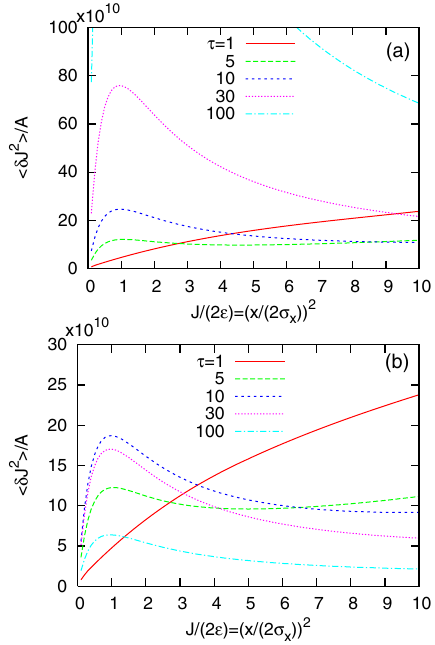
FIG. 18. Diffusion rate given by Eq. (32) as a function of J= ð 2 ϵ Þ for equal tunes δμ ¼ 0 (top) or with a tune difference of δμ ¼ ξ ¼ 0 . 01 (bottom). The rate on the vertical axis is normal- ized by the factor A ¼ ½ N p r p Δ x= ð γσ r Þ(cid:3) 2 = 8 .